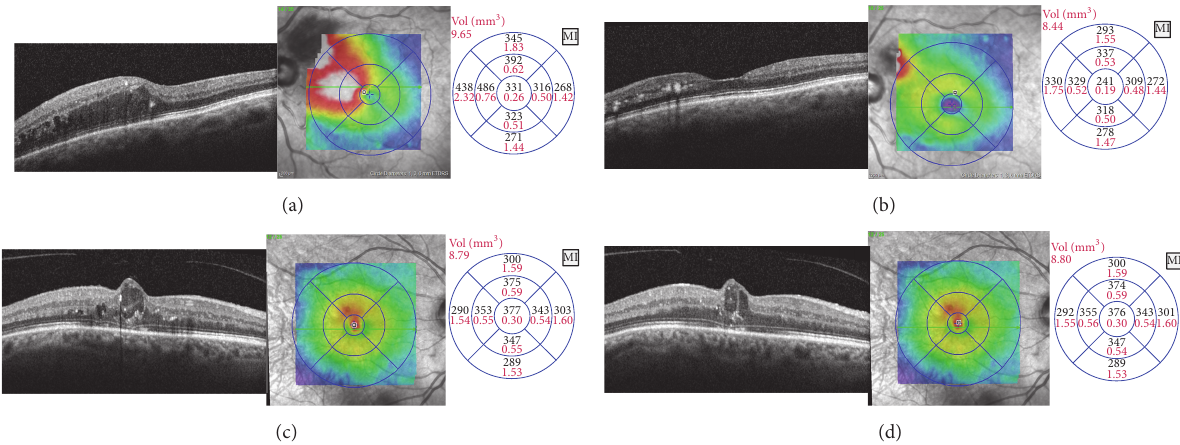
Figure 1: (a) Branch retinal vein occlusion prior to therapy. Macular edema is present in the upper half of the macula. Corresponding color- coded thickness map (middle) and ETDRS mean retinal thickness values are shown (left). (b) 4 weeks after the loading phase (3 monthly injections of ranibizumab) the edema disappeared. Intraretinal exudates are still present. Central retinal thickness decreased from 331 to 241 𝜇 m. ETDRS visual acuity improved from 42 to 75 letters. (c) OCT findings in central retinal vein occlusion prior to therapy. A larger cyst can be appreciated in the foveal area. Central retinal thickness is 377 𝜇 m. (d) After the loading phase, central retinal thickness remained virtually unchanged. The cystic appearance of the retina is still present. ETDRS visual acuity improved from 45 to 48 letters.